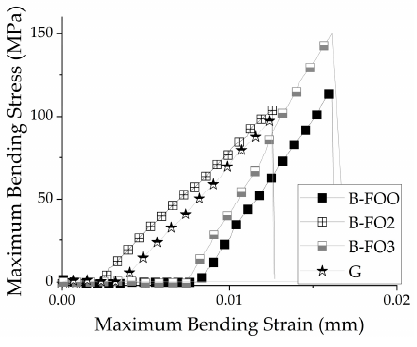
Figure 5. Flexural test . Figure 5. Flexural